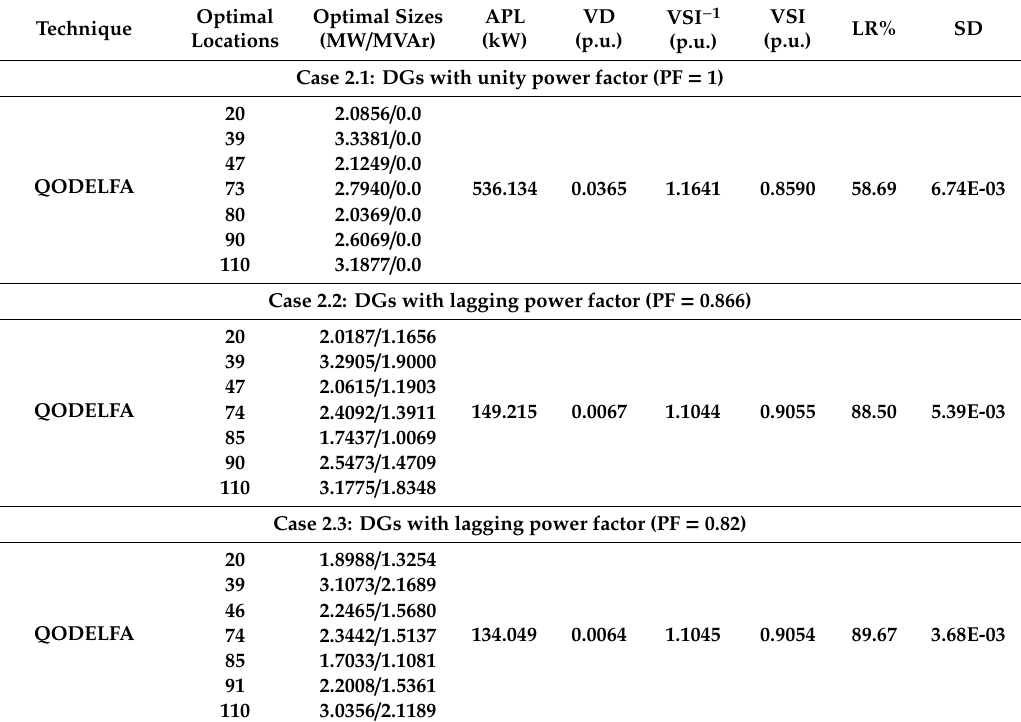
Table 10. Results for the IEEE 118-bus RDS with simultaneous minimization of OF 1 and OF 2 . Technique